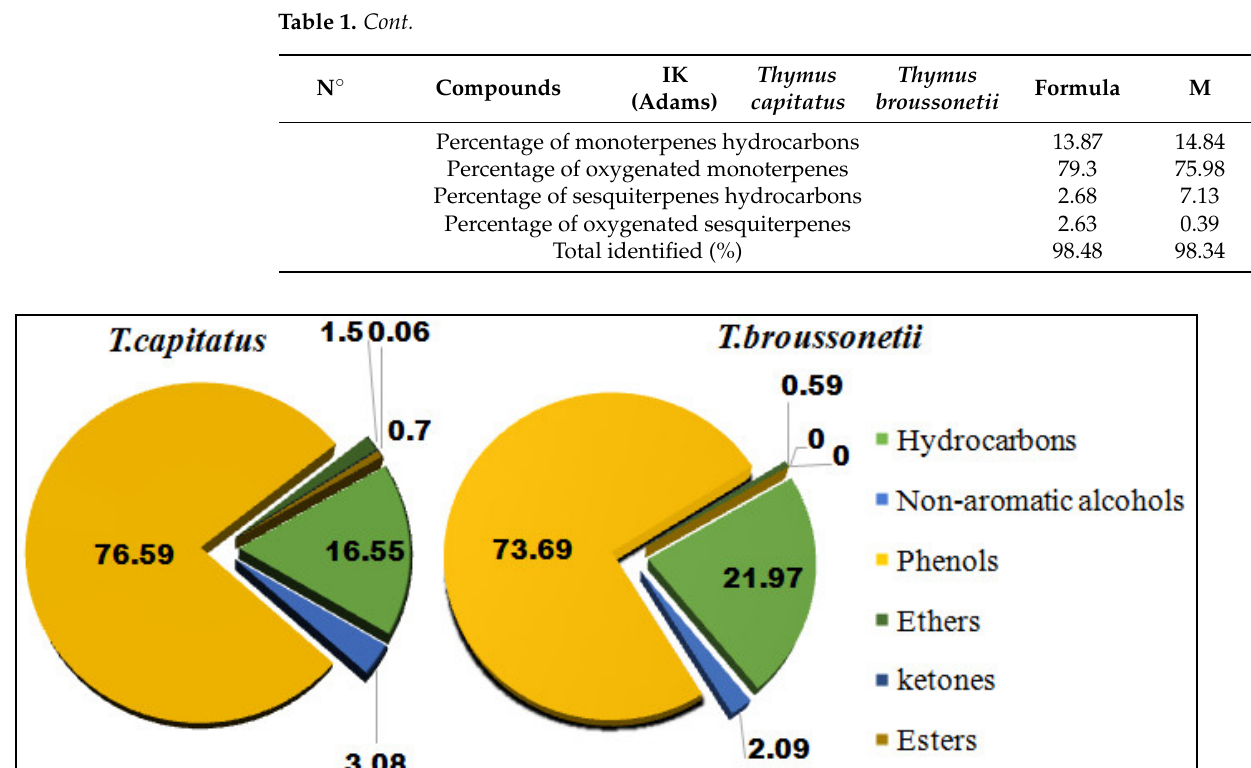
Figure 2. Distribution of the main chemical families of T. capitatus and T. broussonetii EOs. 2.3. Antioxidant Activity of T. capitatus and T. broussonetii Essential